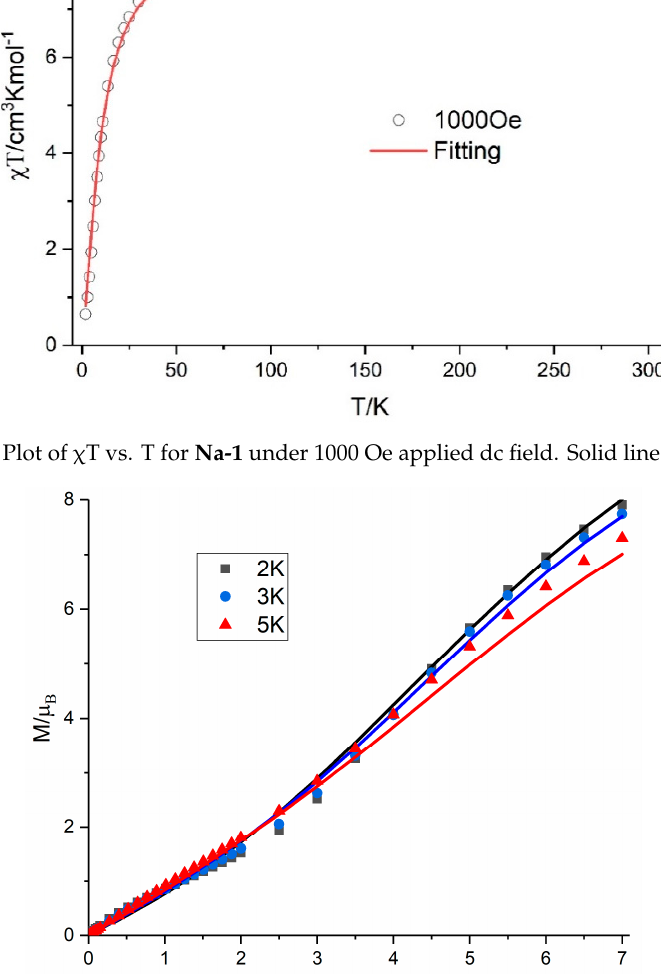
Figure S1: FT-IR spectra of pure Na-1 (black) and mixture of product obtained in absence of (Me 2 NH 2 ) + cation (red), Figure S2: Thermogravimetric analysis (TGA) curve of Na-1, Figure S3: Plot of chiT vs. T under 1000 Oe for compound Na-1